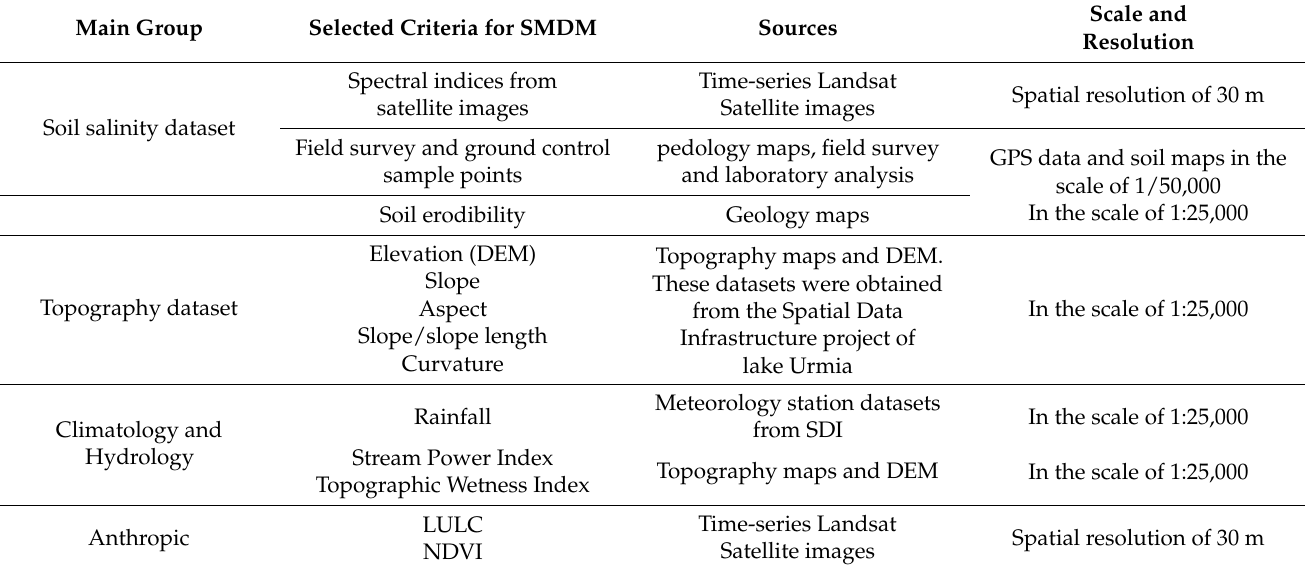
Table 2. List and details of datasets used for soil salinity monitoring and degradation